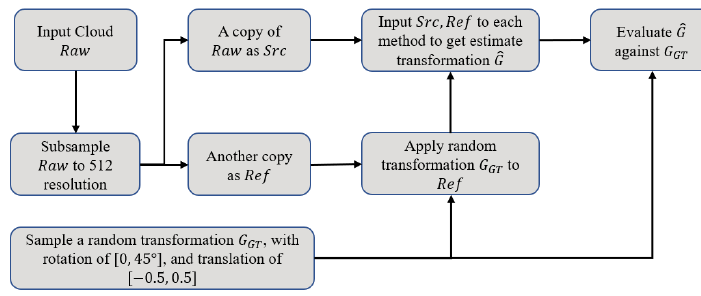
Table 1. Parameters of PMDNet